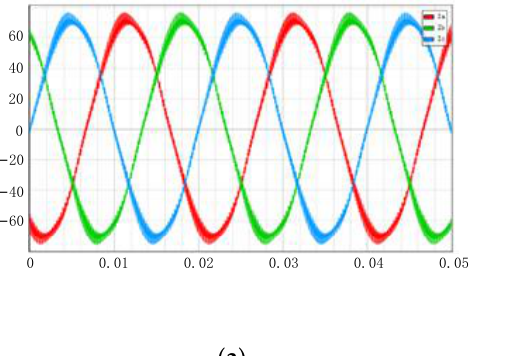
Figure 11. Waveforms of grid current i ga under different grid impedance. ( a ) L g = 1 mH; ( b ) L g = 0 mH.